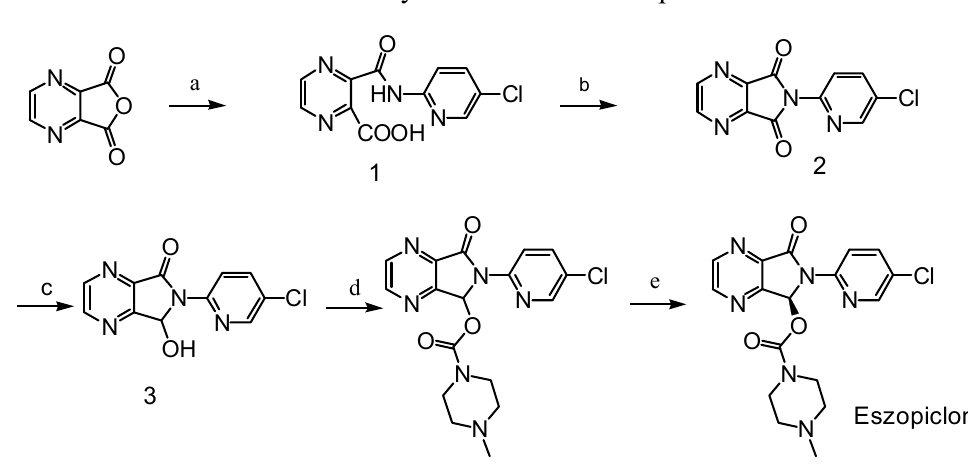
Scheme 1 . Synthetic route to